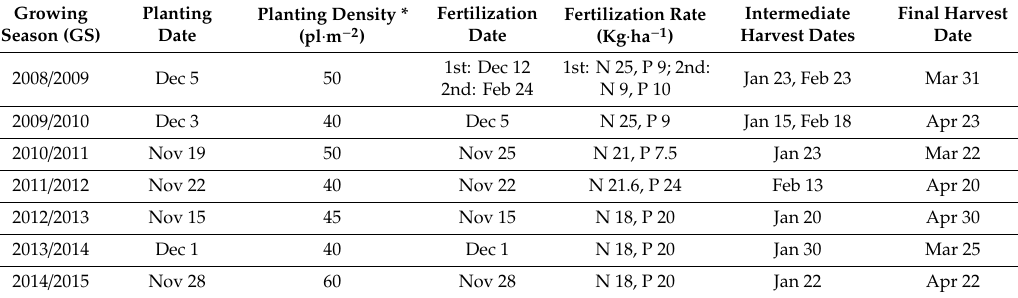
Table 3. Detail of forage sorghum management practices in each evaluated